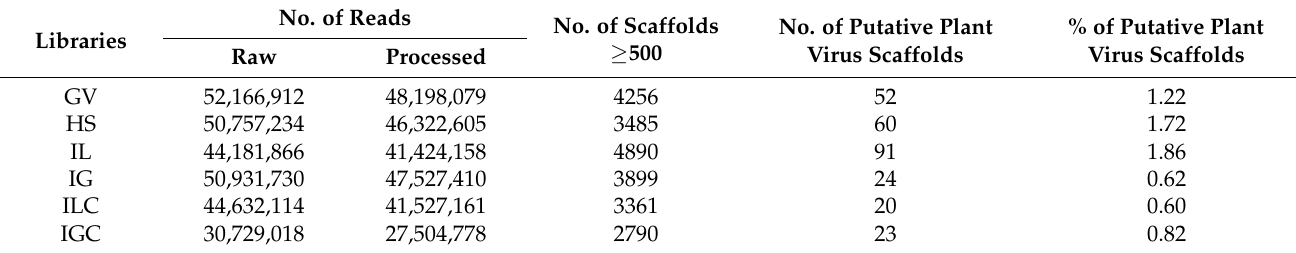
Table 1. The number of processed reads and scaffolds, and the percentage (%) of putative plant virus scaffolds for each RNA library corresponding to different sampling sites. Adapted from